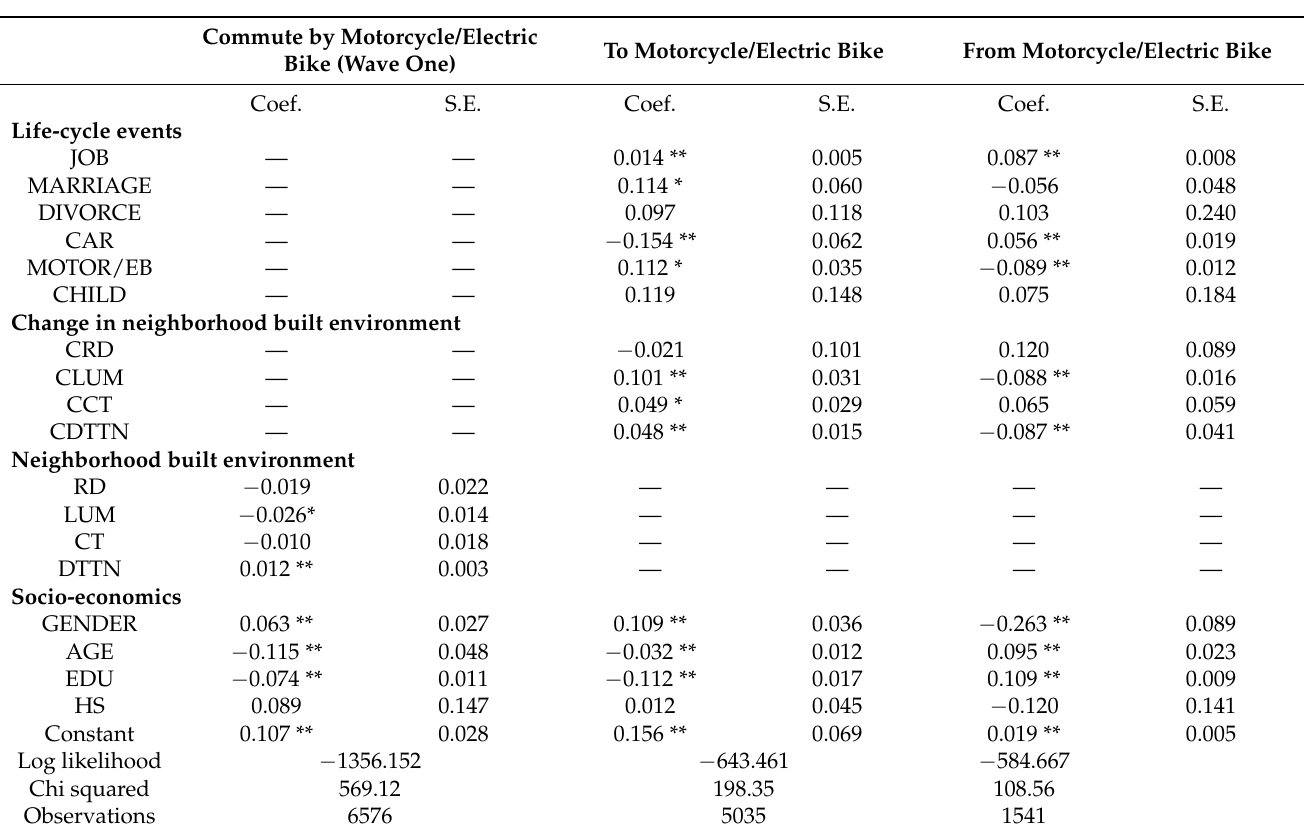
Table 5. Logistic models of motorcycle/electric bike commuting and switches to and from this